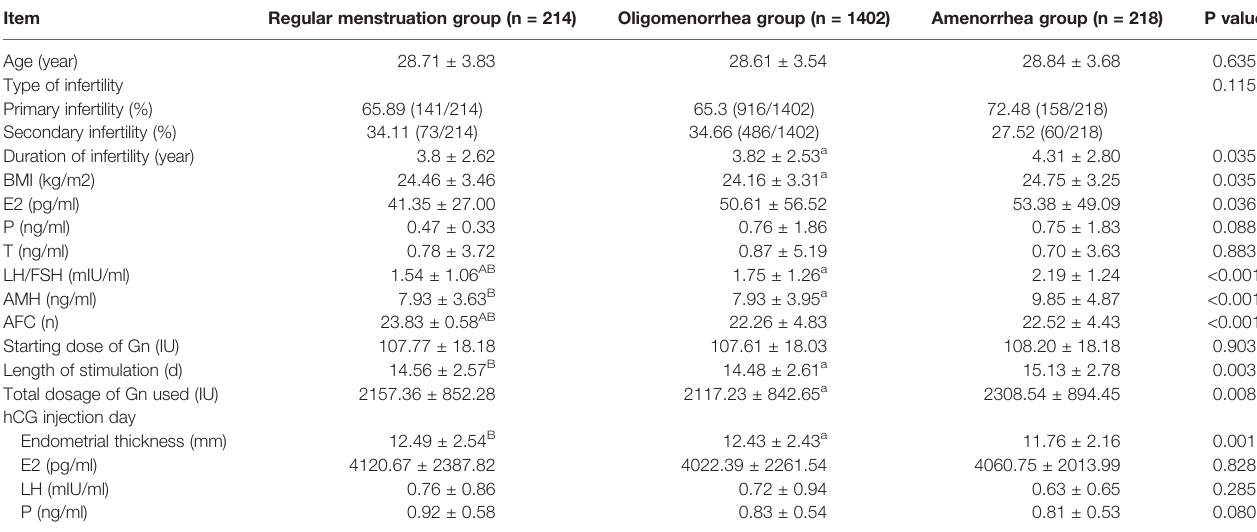
TABLE 1 | Comparison of patients ’ general characteristics and ovulation induction information.